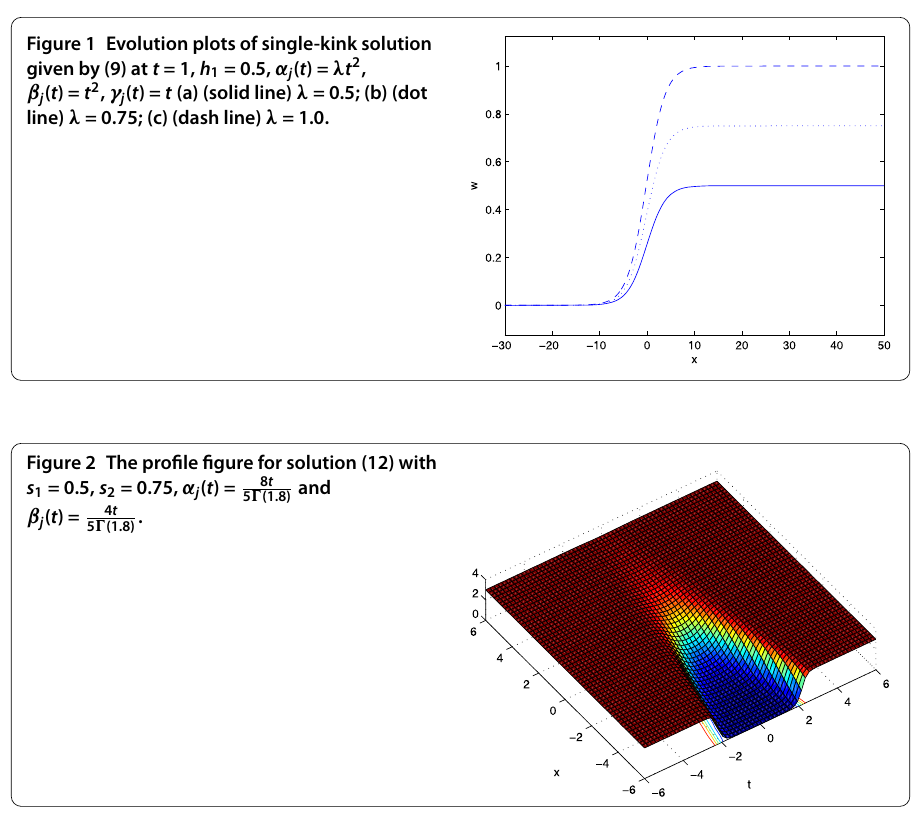
Figure 1 Evolution plots of single-kink solution given by (9) at t = 1, h 1 = 0.5, α j ( t ) = λ t 2 ,